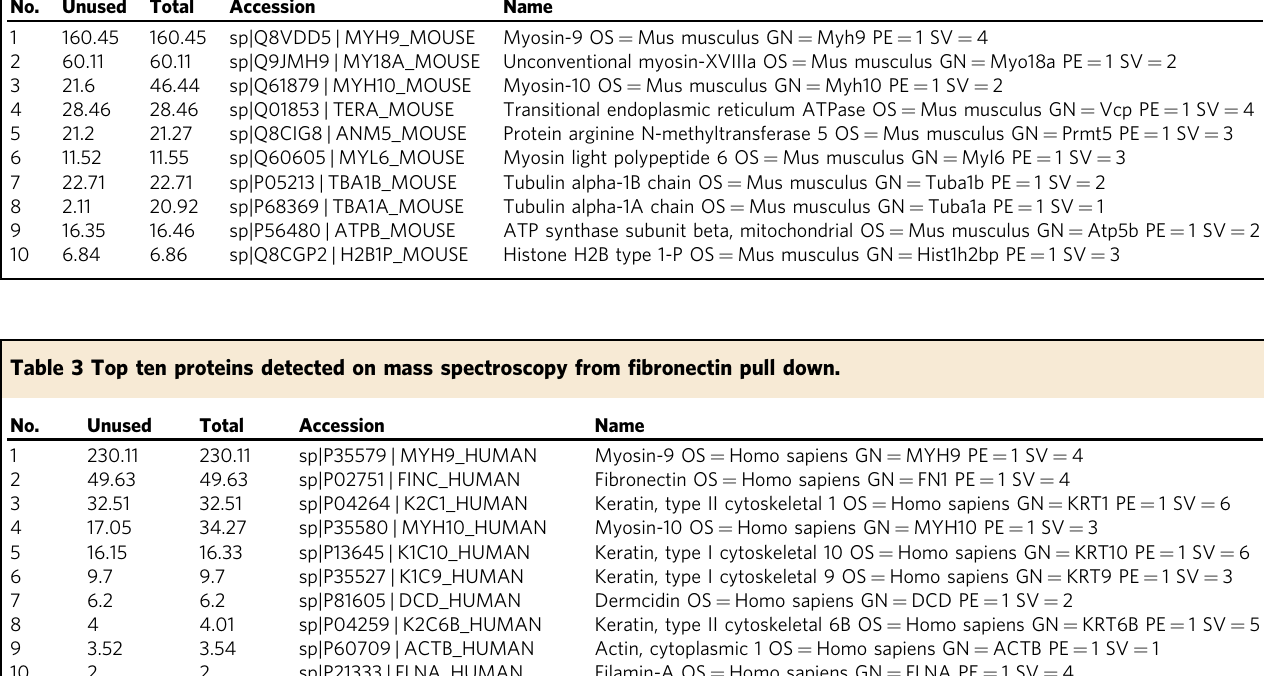
Table 2 Top ten proteins detected by mass spectrometry from FKRP pull down. No. Unused Total